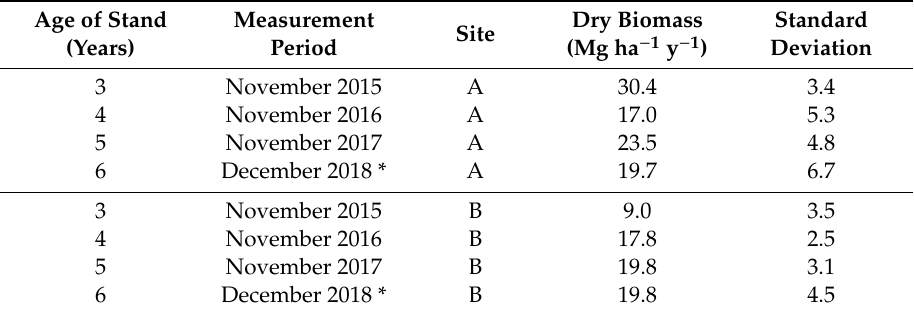
Table 2. Summary of miscanthus dry biomass yields with no fertilizer applied from 2015 to 2018 (with standard deviations) (n = 3 for all